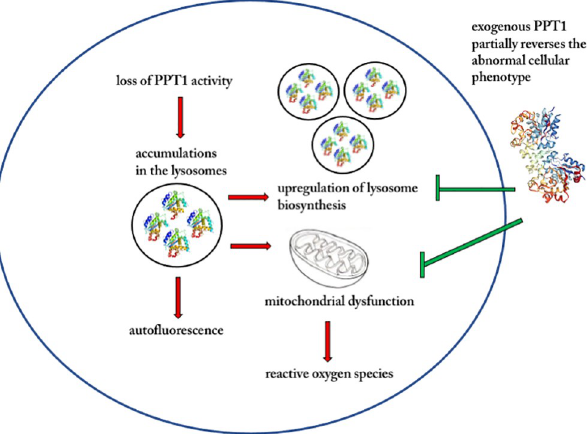
Fig 9. Proposed model of the role of organellar network and ROS response pathway in INCL pathology. The loss of PPT1 protein activity leads to the accumulation of unwanted autofluorescence materials in the lysosomes. At a critical accumulated level, the affected cell exhibits abnormal upregulation of lysosomal biosynthesis and mitochondrial dysfunction and with elevated susceptibility to reactive oxygen species. These pathologies can be mitigated by the addition of extracellular